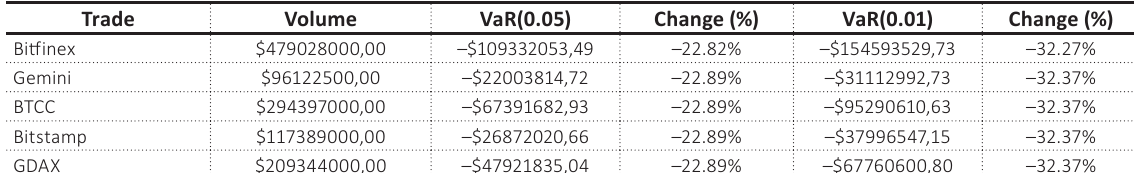
Table 3. Investment risk for selected exchanges and confidence levels with a period of 10 days